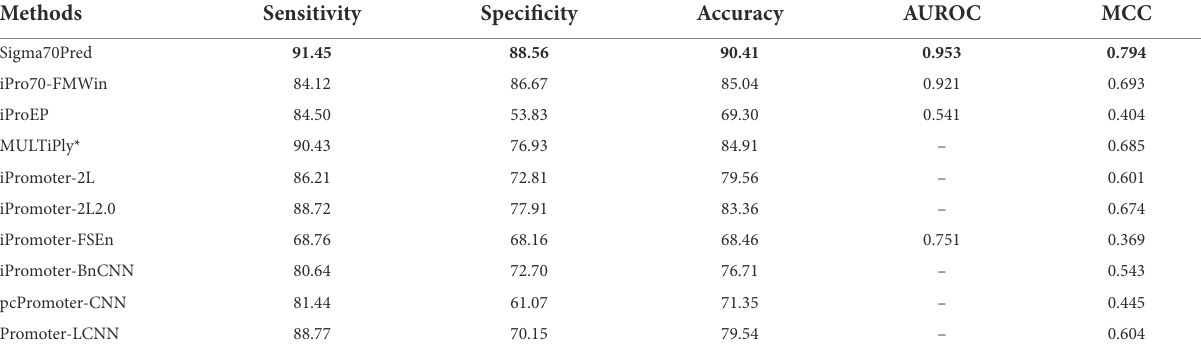
TABLE 3 The performance of existing methods on independent